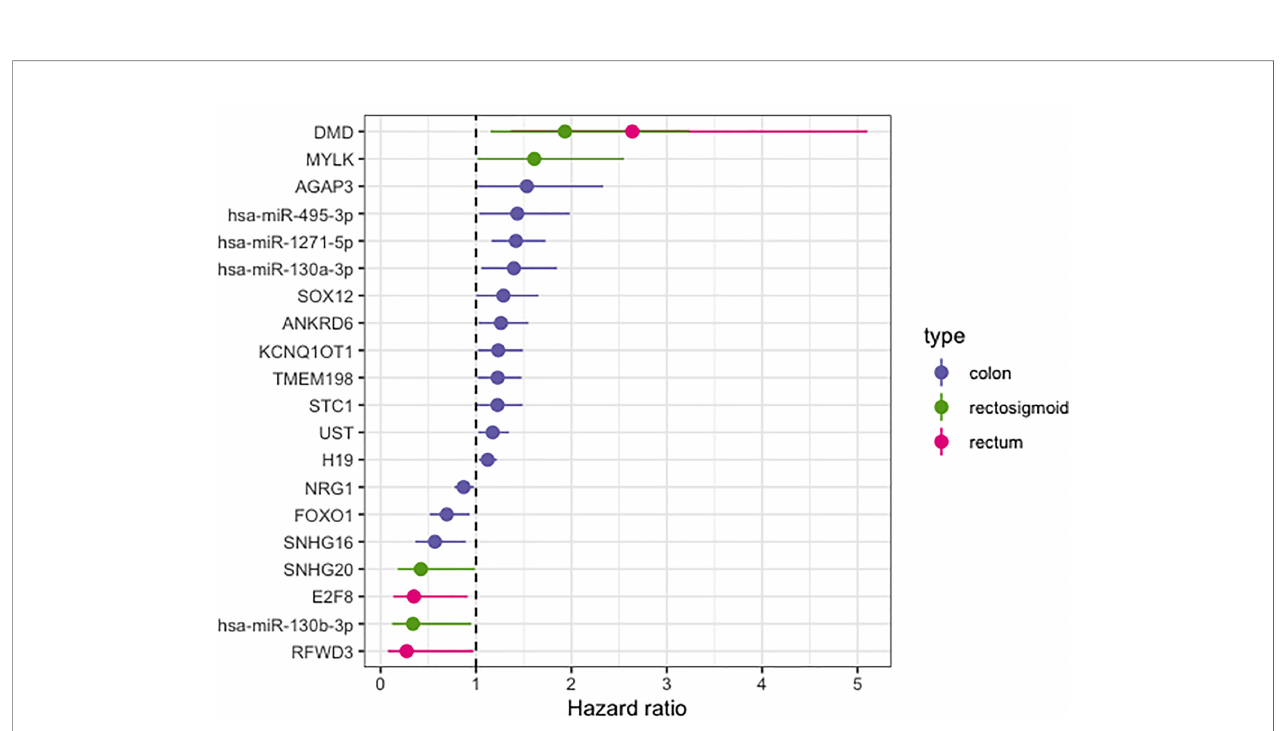
FIGURE 6 | Hazard ratio forest plot of survival associated RNAs in the ceRNA network for colon, rectum and rectosigmoid junction sites. The molecules with hazard ratio < 1 indicate risk factors, and those with hazard ratio > 1 indicate protective